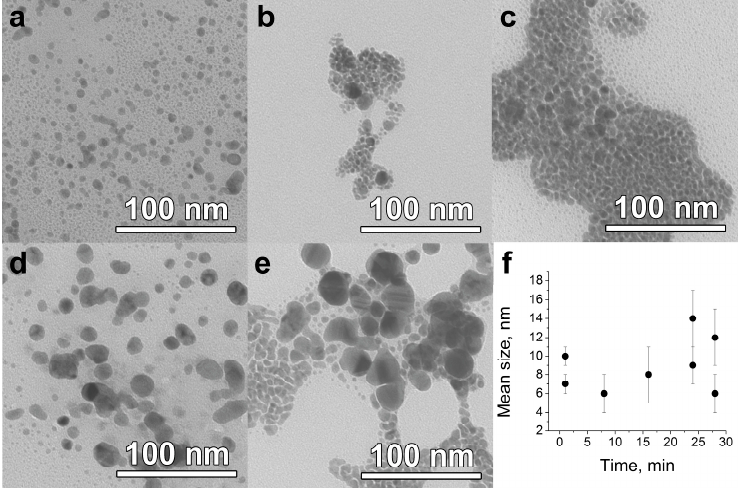
Figure 2. Transmission electron microscopy (TEM) micrographs of silver colloids synthesized via UV-induced photochemical reduction of silver citrate in water polyol 1H 2 O:1EG media. Time of UV illumination: ( a ) 1 min; ( b ) 8 min; ( c ) 16 min; ( d ) 24 min; and ( e ) 28 min. Mean particle size (estimated from >300 particles as visualized by TEM) vs. duration of UV illumination is plotted ( f ). Note that 24–28 min of UV irradiation results in bimodal particle size distribution.